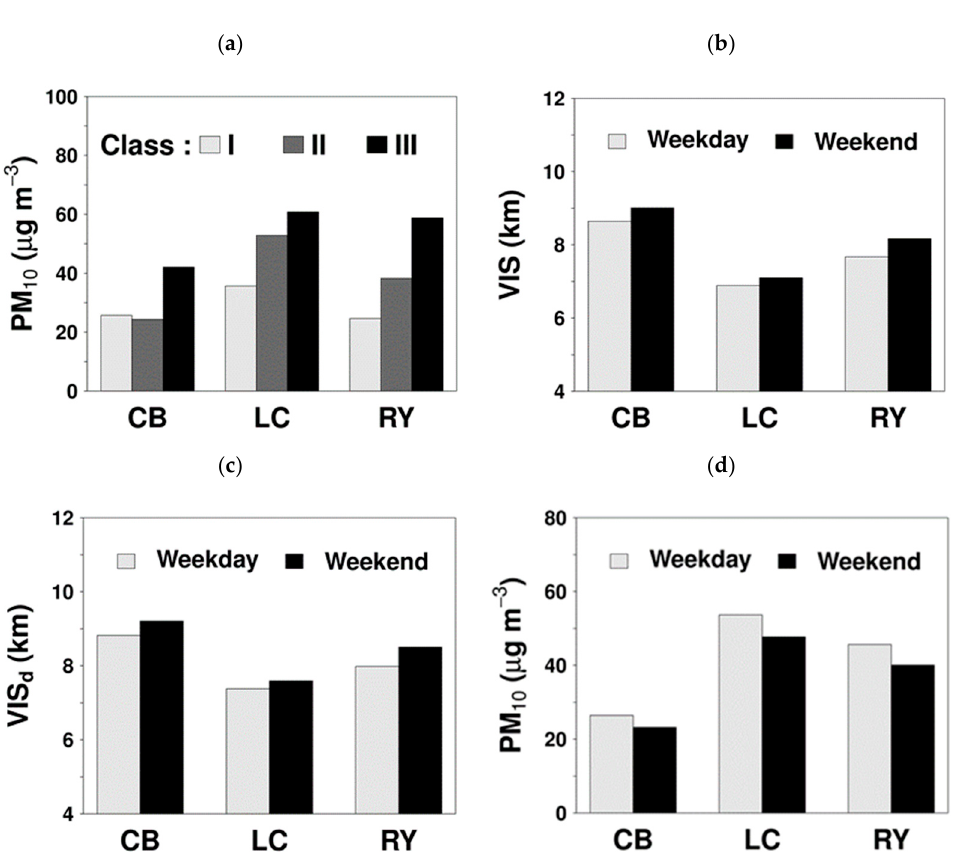
Figure 4. ( a ) average PM 10 by visibility class and by station, and ( b – d ) average visibility, relative humidity ( RH )-corrected visibility, and PM 10 , respectively, at stations CB, LC, and RY during the weekdays (Monday–Saturday) and the weekend (Sunday plus holidays). The difference in any pair of mean values in the above results is statistically significant at the 0.05 level.